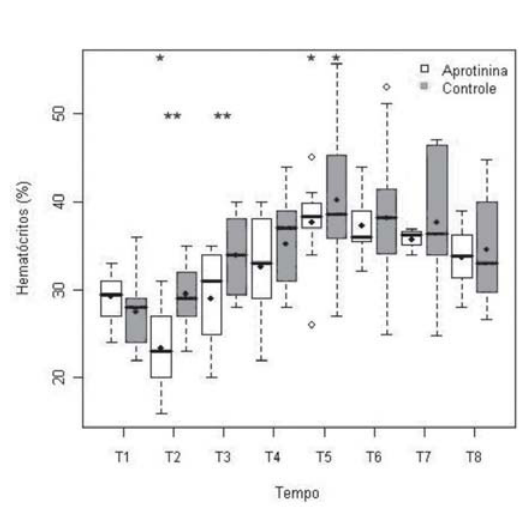
Fig. 3 - Contagem de plaquetas (n° x 10³/mm³) nos grupos Aprotinina e Controle. As diferenças intragrupos e intergrupos estatisticamente significativas estão